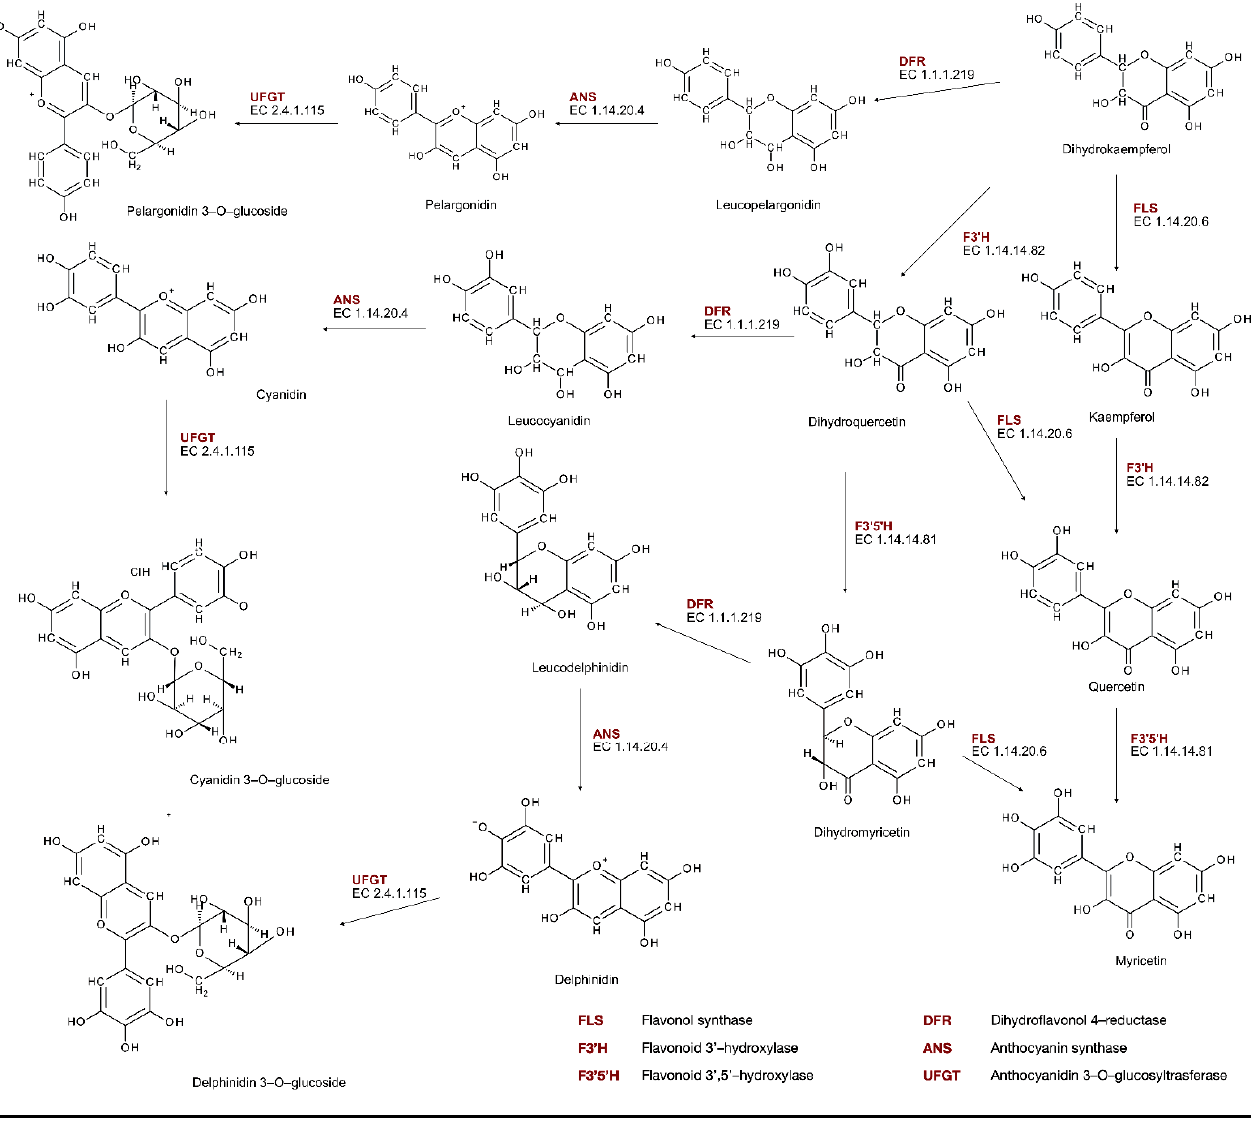
Figure 2. Phenolic compounds biosynthesis pathway.